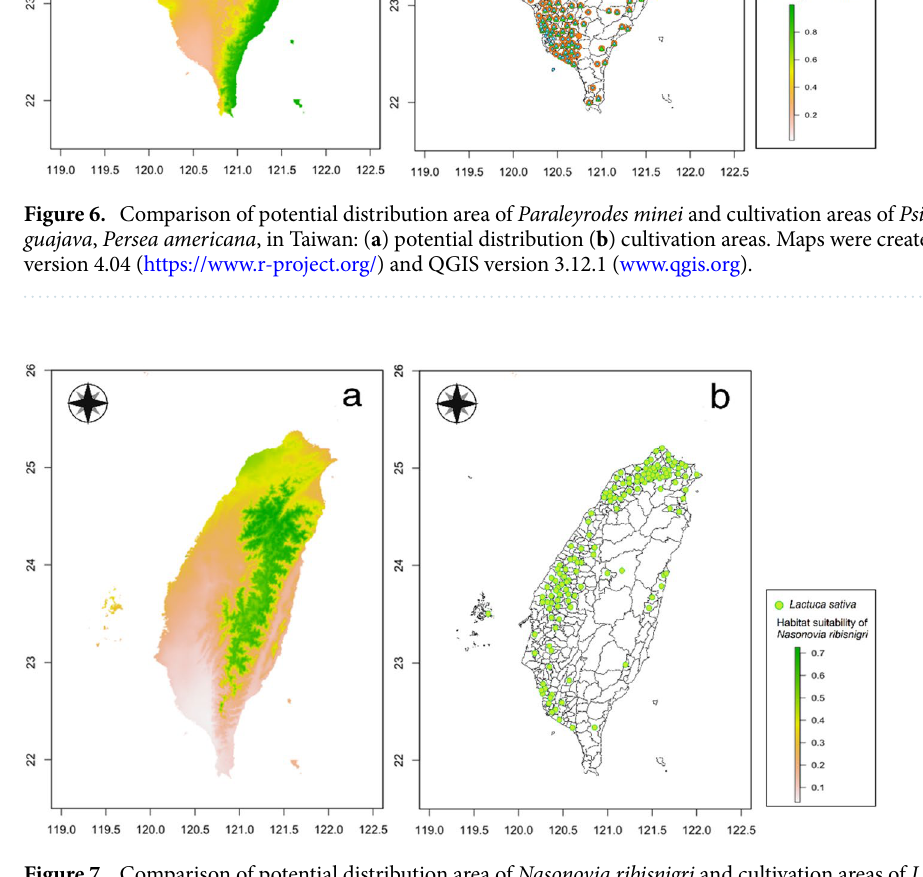
Figure 7. Comparison of potential distribution area of Nasonovia ribisnigri and cultivation areas of Lactuca sativa in Taiwan: ( a ) potential distribution ( b ) cultivation areas. Maps were created using R version 4.04 (https:// www.r- proje ct. org/) and QGIS version 3.12.1 (www. qgis.